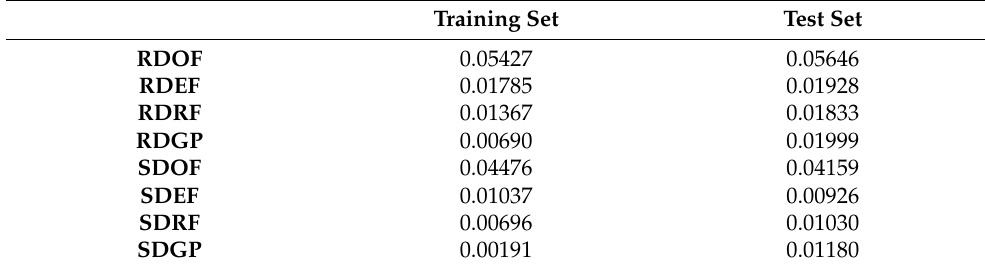
Table 4. RMSE mean values of bootstrap training and out-of-the-bag test sets. RMSE units: kg/(s ·